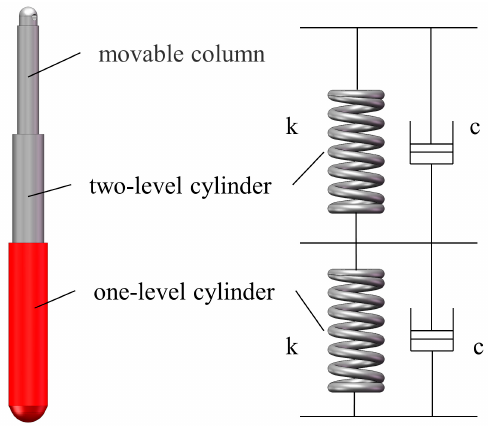
Figure 2. Equivalent replacement of column and spring damping model.